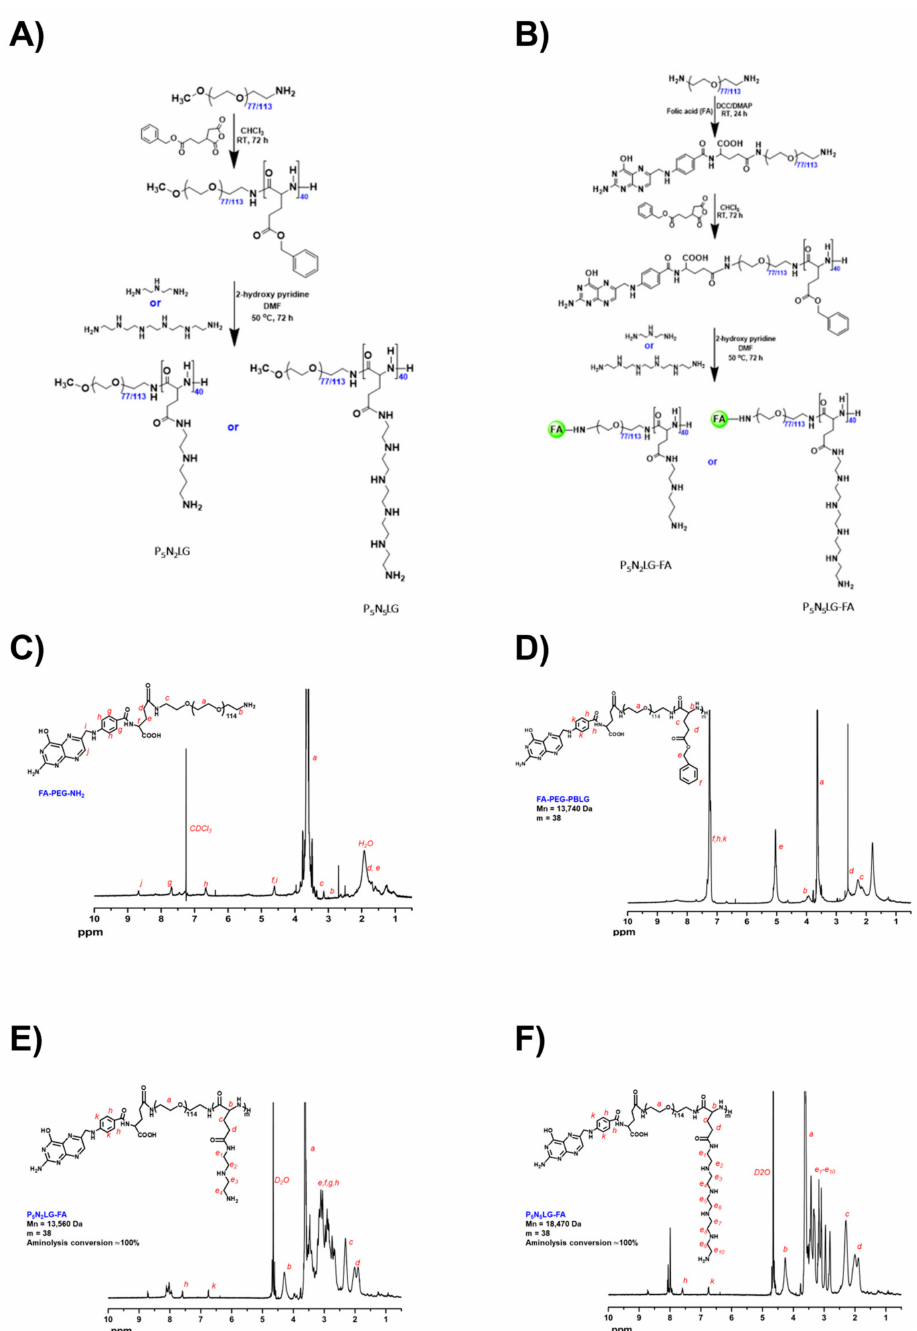
Figure 1. Synthesis scheme of PNLG polymers. ( A ) Synthesis of PNLG copolymers (P 5 N 2 LG and P 5 N 5 LG control polymers). ( B ) Synthesis of PNLG-FA copolymers. 1 H NMR spectra of ( C ) FA-PEG-NH 2 polymer, ( D ) FA-PEG-PBLG, ( E ) P 5 N 2 LG-FA, and ( F ) P 5 N 5 LG-FA